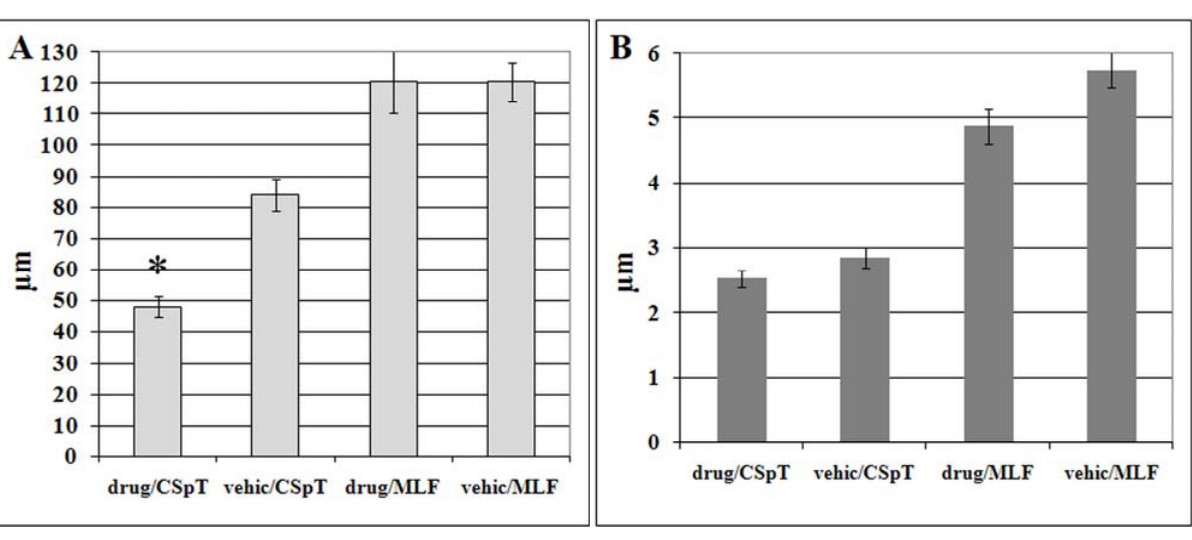
Figure 2. Bar chart of the mean length ( A ) and thickness ( B ) of traumatically injured axons (displaying HRP-accumulation) in the corticospinal tract (CSpT) and in the medial longitudinal fasciculus (MLF) in vehicle- (vehic) and MDL-28170-treated (drug) animals subjected to impact acceleration injury. Error bars represent standard error of mean (SEM); asterisks indicate statistically significant difference of mean density